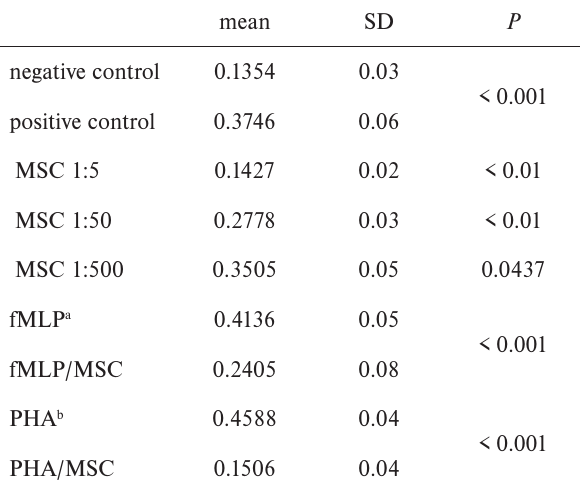
Table 1. Lymphocyte cytotoxicity test (MTT absorbance values).